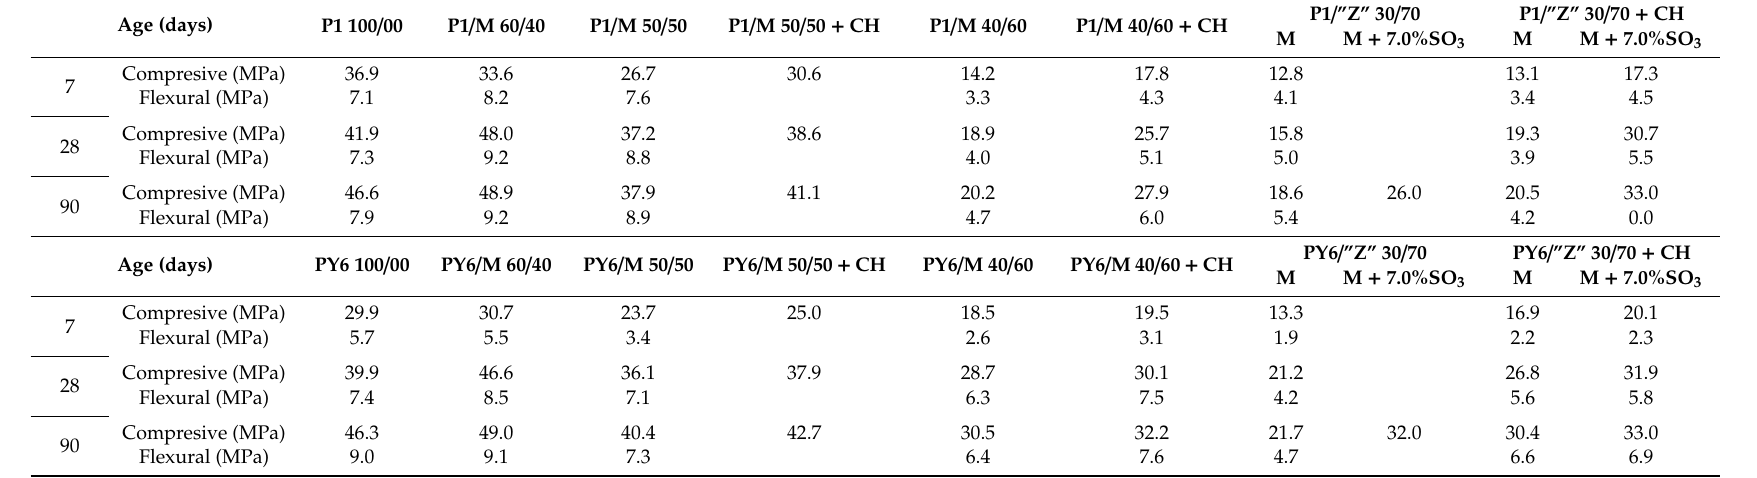
Table 2. Flexural and compressive strength